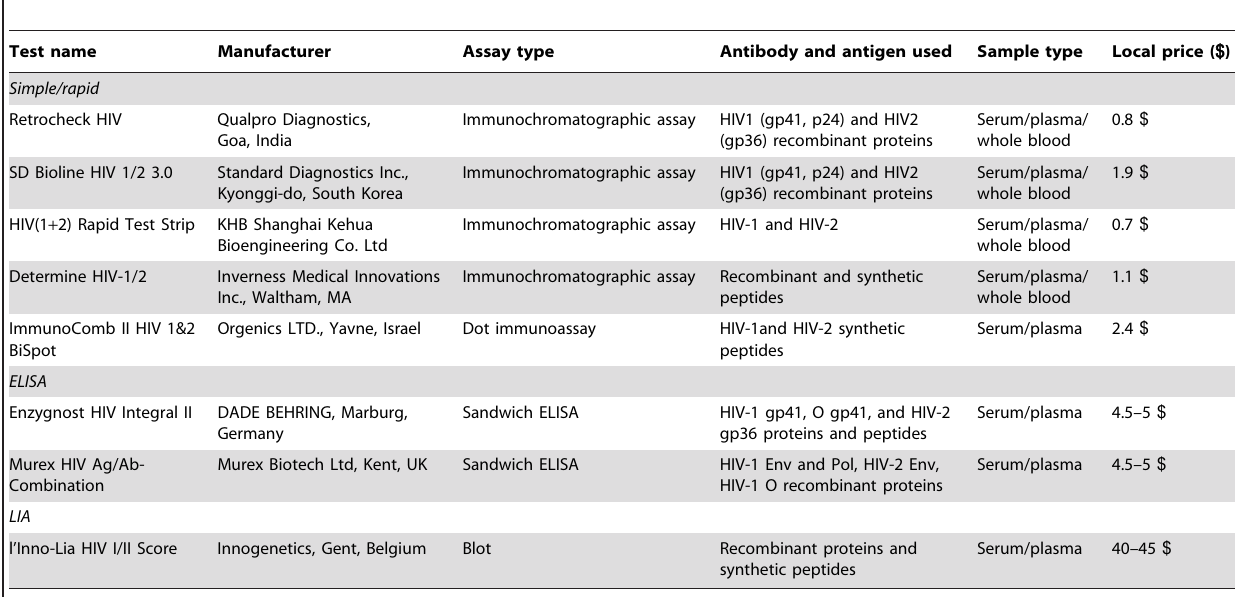
Table 1. Characteristics of the HIV diagnostic assays evaluated as described by